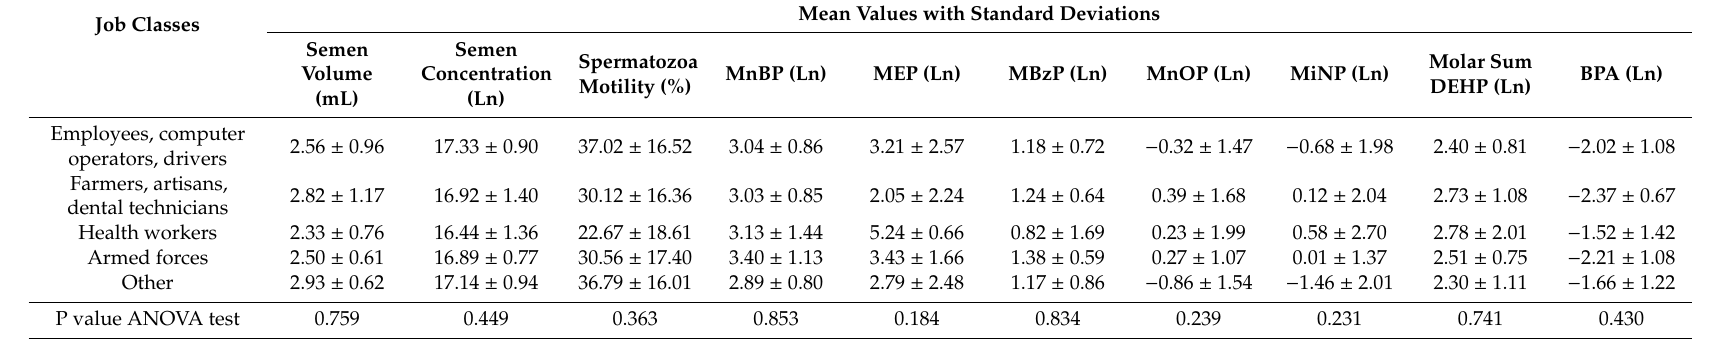
Table 5. Data stratification for job